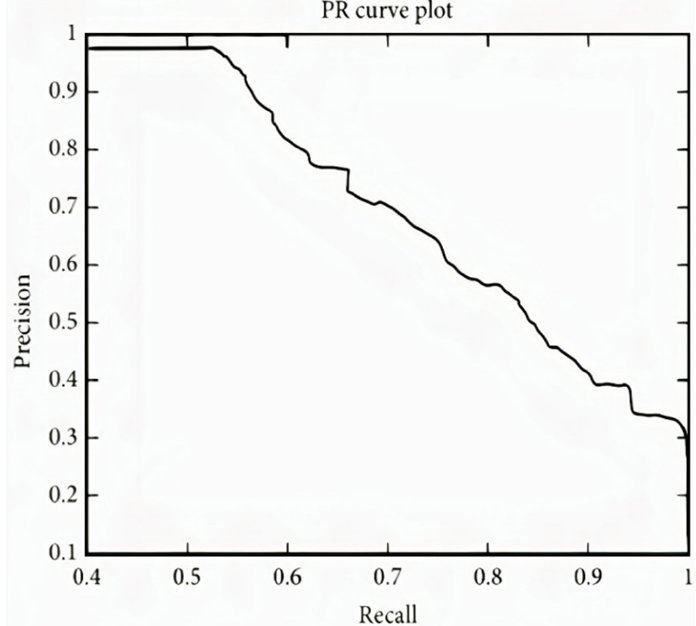
Figure 14. PR curve of valence label.